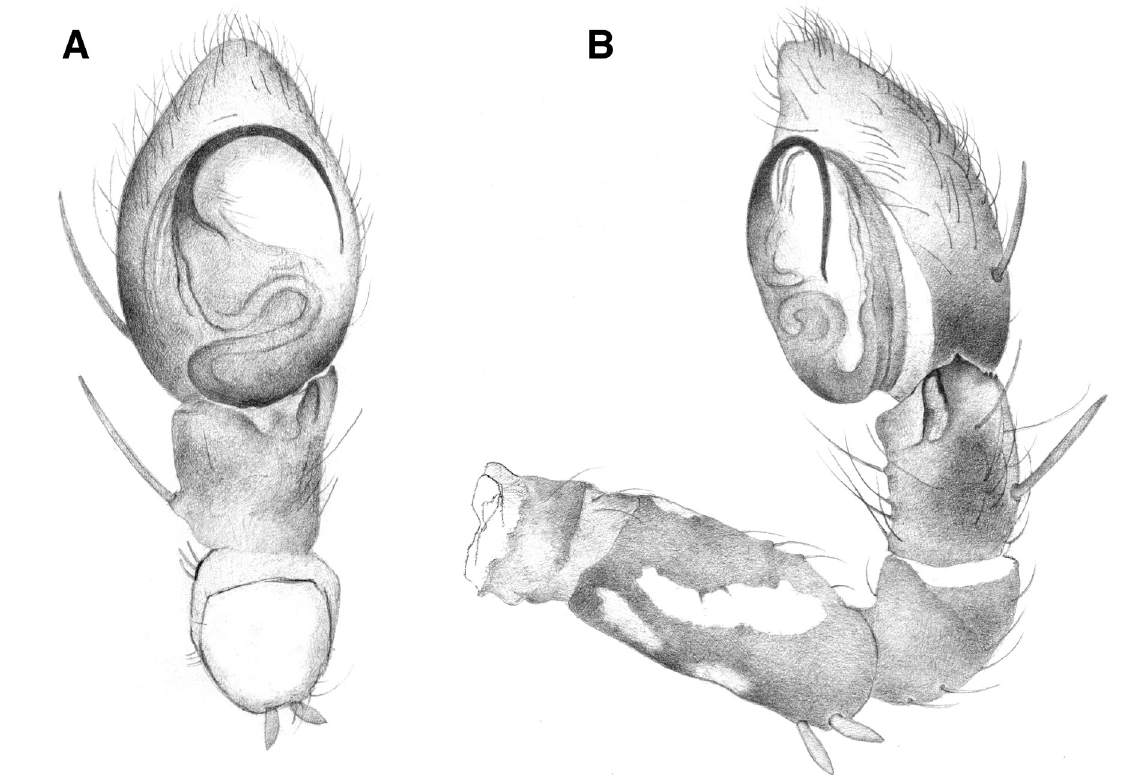
Fig. 8. Apollophanes (?) lonesomegeorgei sp. nov. A . ♂ palp, ventral view. B . ♂ palp, retrolateral